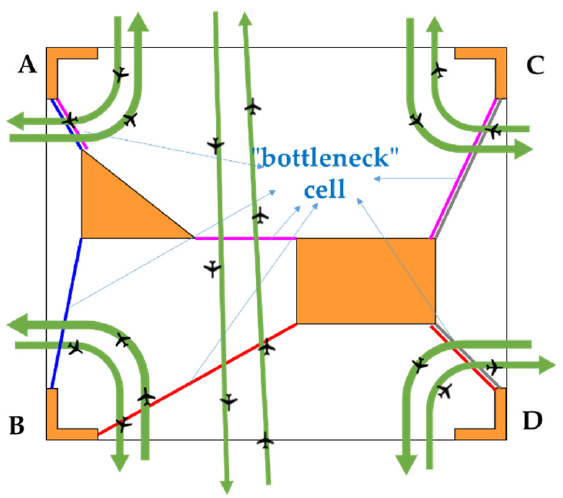
Figure 4. “L” shaped angle constraint and “bottleneck” cell.